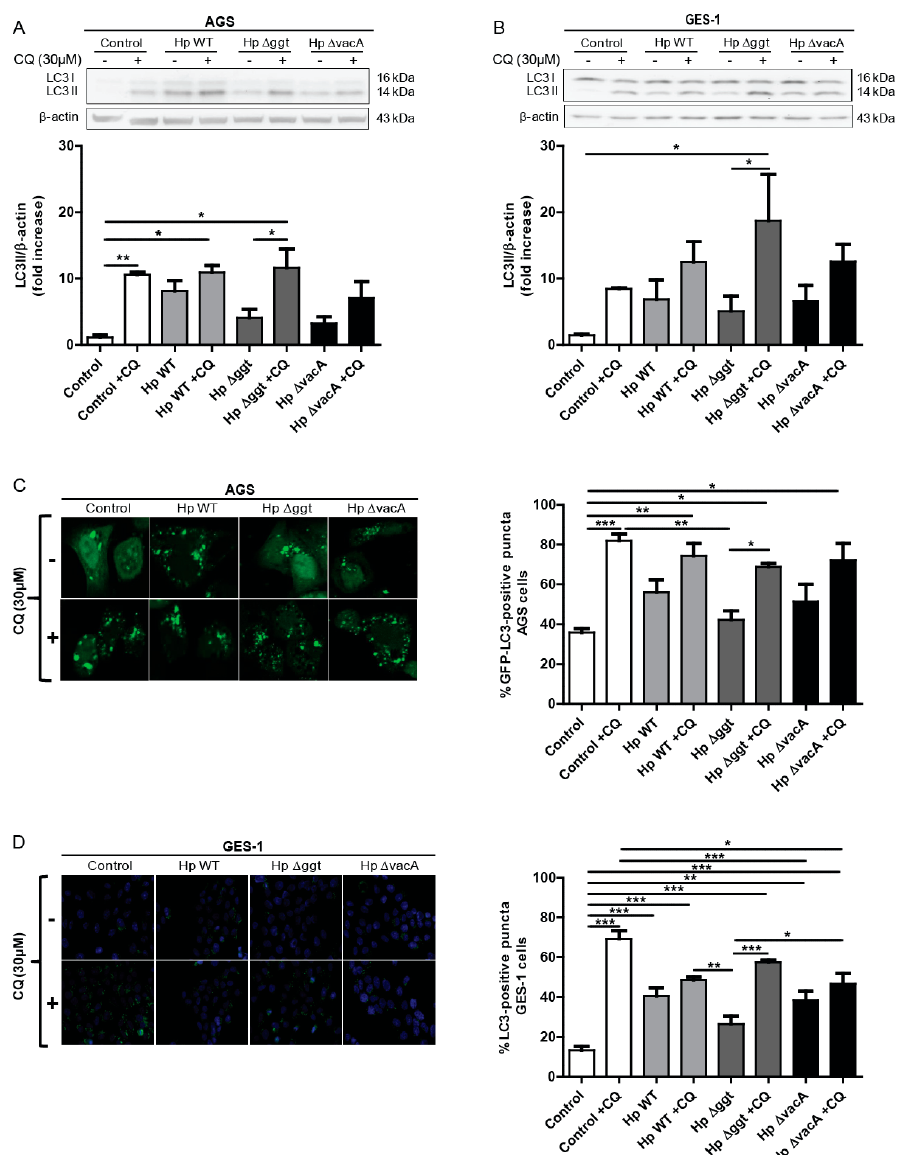
Figure 1. The isogenic mutant ∆ ggt, lacking gamma-glutamyltranspeptidase (GGT), increases autophagic flux after infection of AGS and GES-1 cells when compared with the parental and the isogenic mutant Hp Δ vacA (lacking vacuolating toxin) strains. ( A ) AGS and ( B ) GES-1 cells were infected with wild type (HpWT) or the isogenic mutants Hp ∆ ggt and Hp ∆ vacA for 6 h in the presence or absence of chloroquine (CQ) (30 μ M). Protein levels of the microtubule-associated protein 1A/1B light chain 3 (LC3) conjugated to phosphatidylethanolamine (LC3-II) and β -actin were evaluated by western blotting. To quantify the accumulation of autophagosomal structures in the presence or absence of CQ, ( C ) AGS cells were transiently transfected with the green fluorescent protein (GFP)-LC3-encoding plasmid and ( D ) LC3 endogenous expression was assessed by immunofluorescence in GES-1 cells. Infected cells were imaged for GFP-LC3 and LC3 puncta by confocal microscopy (AGS cells) and fluorescence microscopy (GES-1 cells). Autophagic structures were considered to be positive when the number of GFP-LC3 or LC3 puncta per cell was at least 5 ( ≥ 100 cells per experiment). These data represent the mean ± the standard error of the mean (SEM) of three independent experiments. * p < 0.05, ** p < 0.01, *** p <